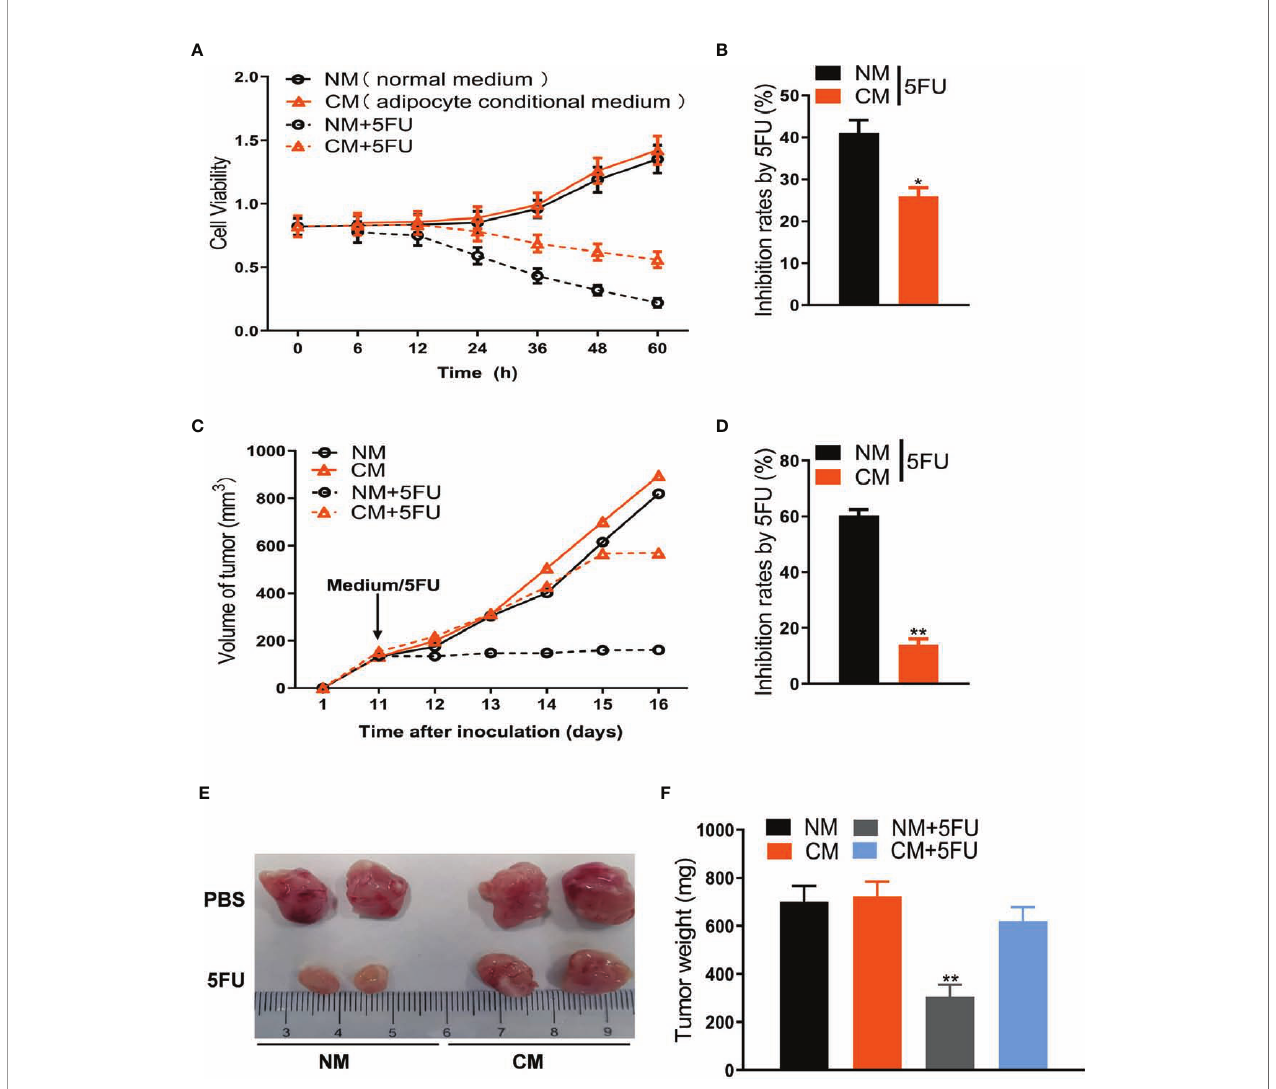
FIGURE 1 | Adipose cells resist 5FU ef fi cacy in CRC treatment. (A) Cell viability of CT26 cells treated with conditional medium and 5FU (10 m mol/L) by CCK8 assays (n = 5). (B) The inhibition rates of 5FU were measured according to (A) (n = 5, * P < 0.05). (C) Adipose cells induce resistance of CT26-tumors to 5FU treatment. CT26 cells (1.0 × 10 6 ) were subcutaneously implanted in BALB/c mice. The treatment with 5FU and/or the conditional medium including NM, CM, and CM (5FU) was initiated when the tumor size reached to around 0.5 cm in diameter. The tumor size was measured dynamically. (D) The inhibition rates based on (C) were calculated (n = 5, ** P < 0.01). (E) The representative images of CT26 tumors (on day 17) from the mice as described in (C) . (F) Weight of CT26 tumors (on day 17) from the mice as described in (C) (n = 5, ** P <